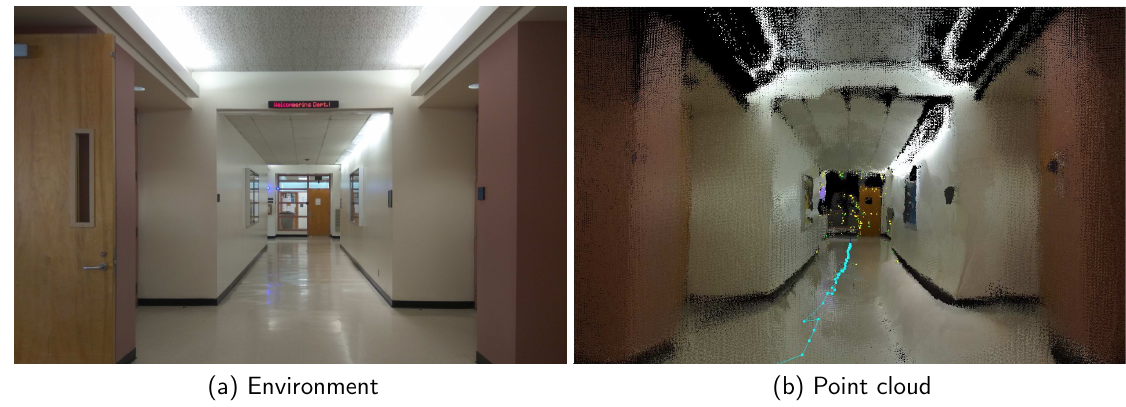
Figure 16. 3D mapping (point cloud) results of the indoor